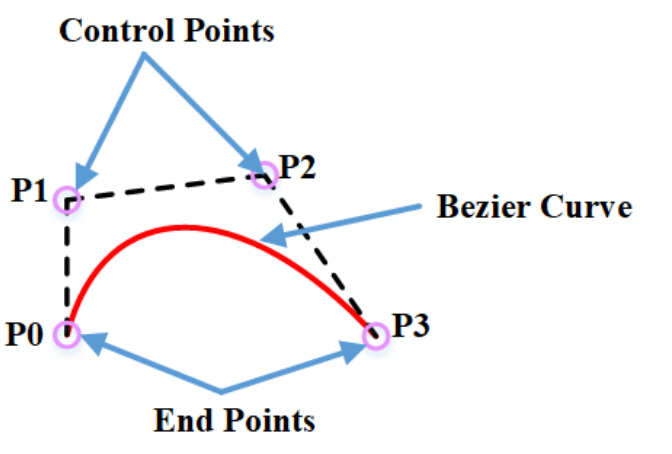
Figure 6. Cubic Bezier Curve.